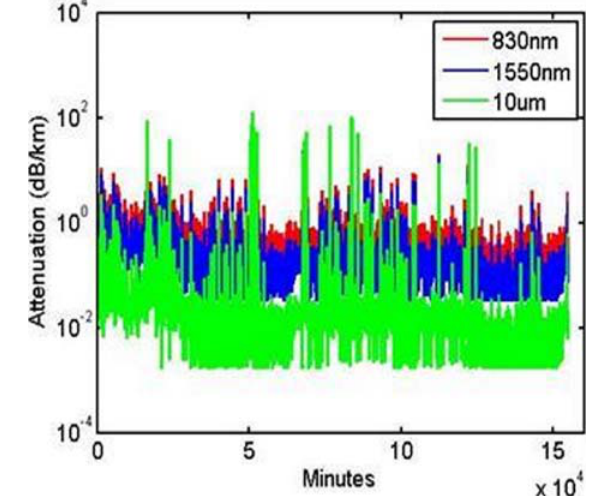
FIG. 15. TIME SERIES PLOT OF ESTIMATED SPECIFIC OPTICAL ATTENUATION BY KIM MODEL FOR 3 YEARS